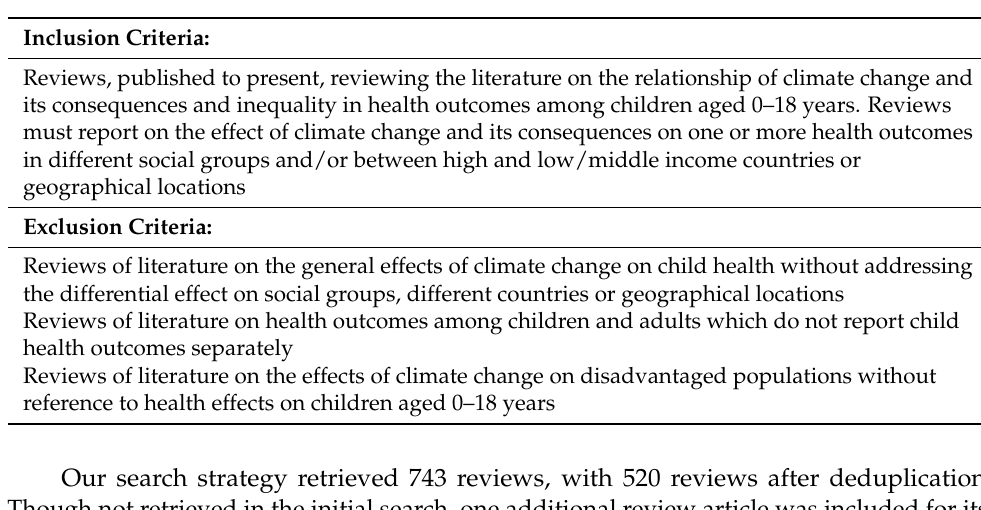
Table 1. Inclusion and exclusion